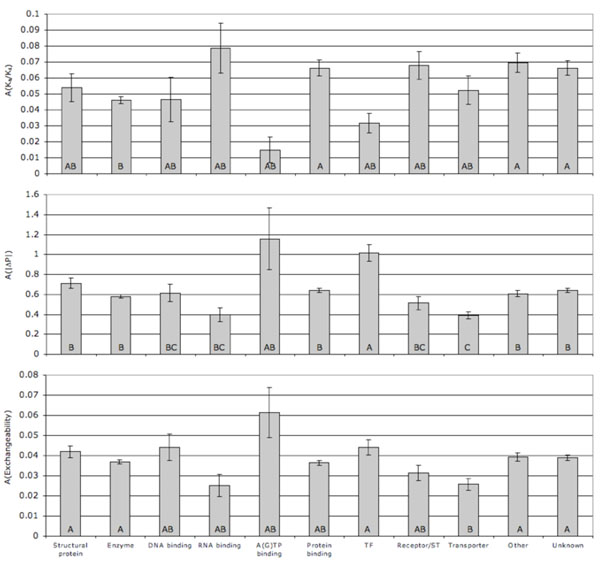
Clade asymmetries in families with duplications. Clade asymmetry (A) in relative substitution rate (top), absolute change in polarity (middle) and exchangeability (bottom) by molecular function. Molecular function category means were calculated by unweighted averaging over families. One-way ANOVA, respectively: F = 3.91, P < 0.00001; F = 7.63, P < 0.00001; F = 2.99, P < 0.001. Different letters signify categories different by Tukey-Kramer test, P = 0.05.